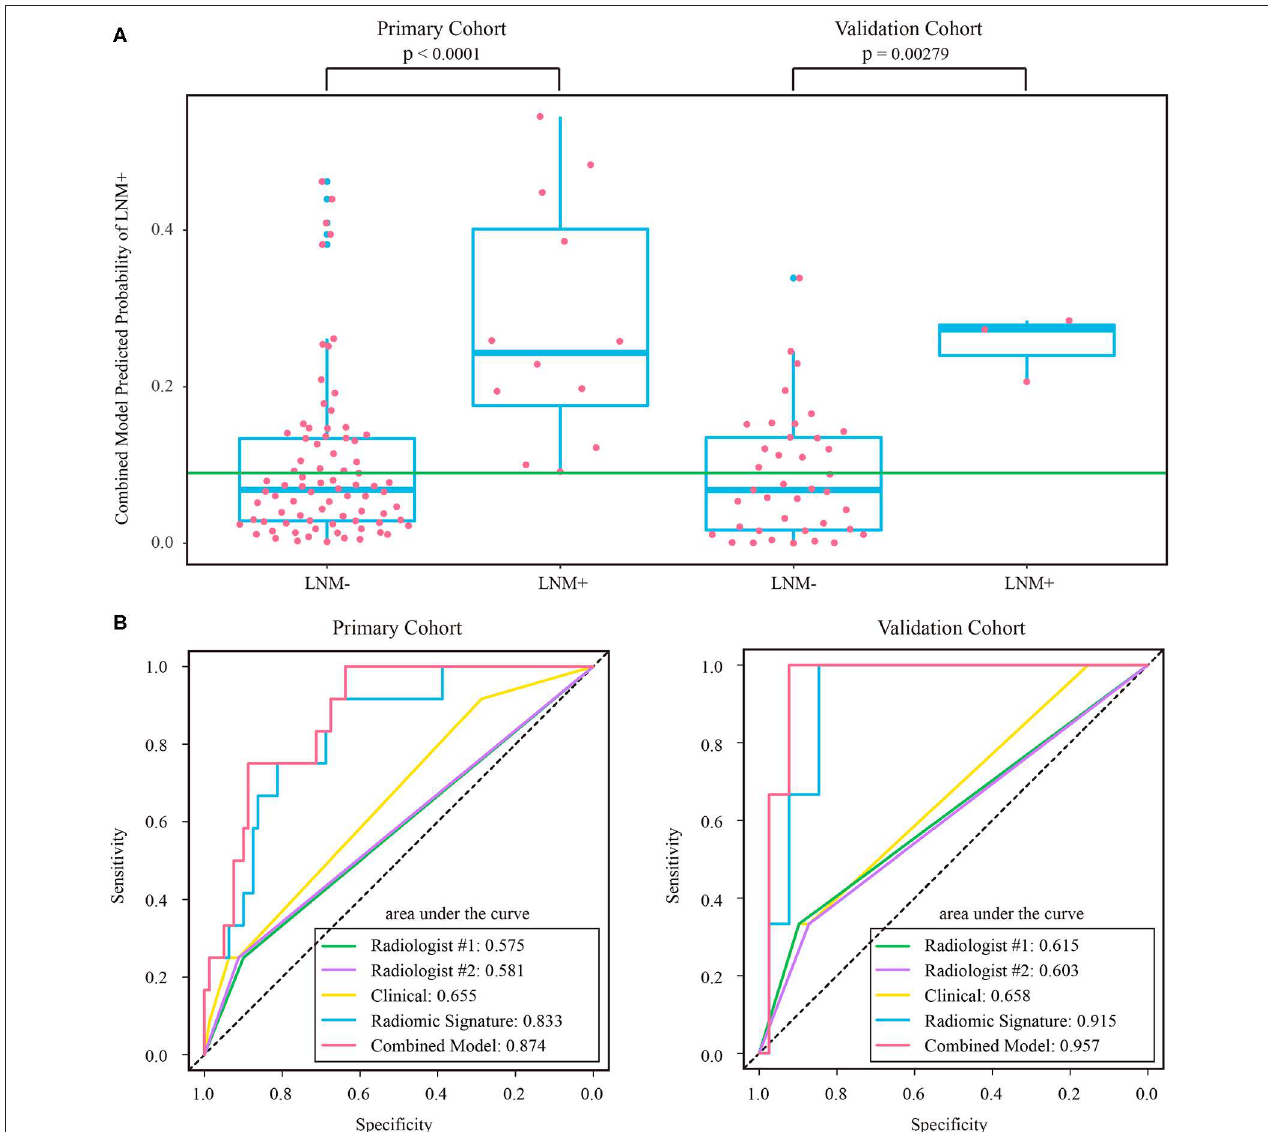
FIGURE 5 | (A) Distribution of combined model predicted probability of LNM + in post-therapeutic ymrT1-2 subgroups of both cohorts, where the green line indicates the Youden cutoff in the primary cohort. (B) ROC curves of radiologists’ and prediction models in post-therapeutic ymrT1-2 subgroups of both cohorts. LNM + , lymph node metastasis; LNM-, lymph node non-metastasis; ROC, receiver operating